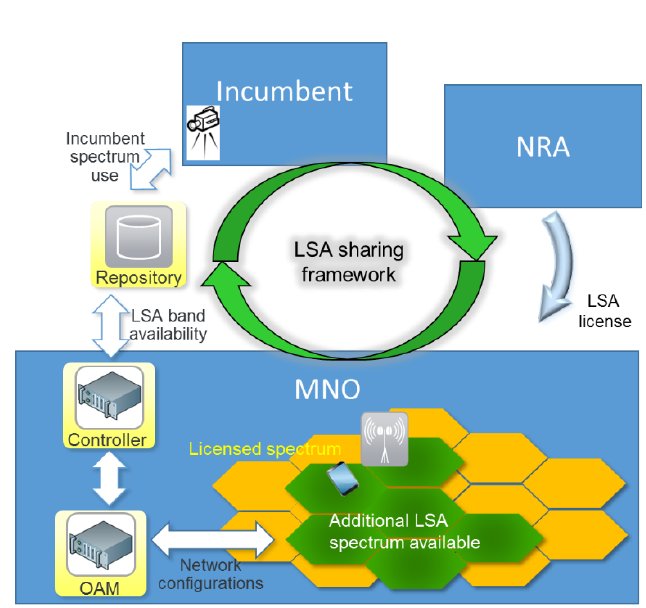
Figure 1. LSA concept, key stakeholders and building